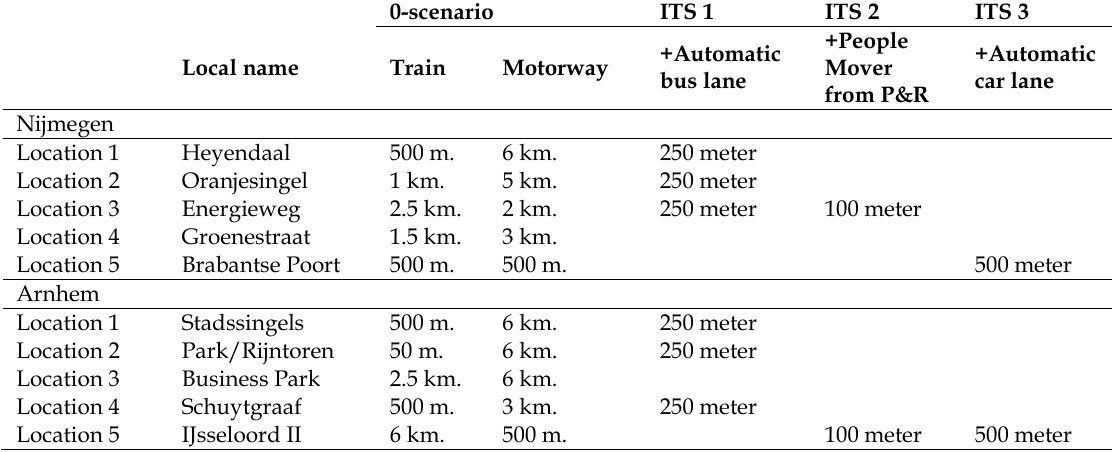
Table 2. Accessibility profile of selected office locations in Arnhem and Nijmegen